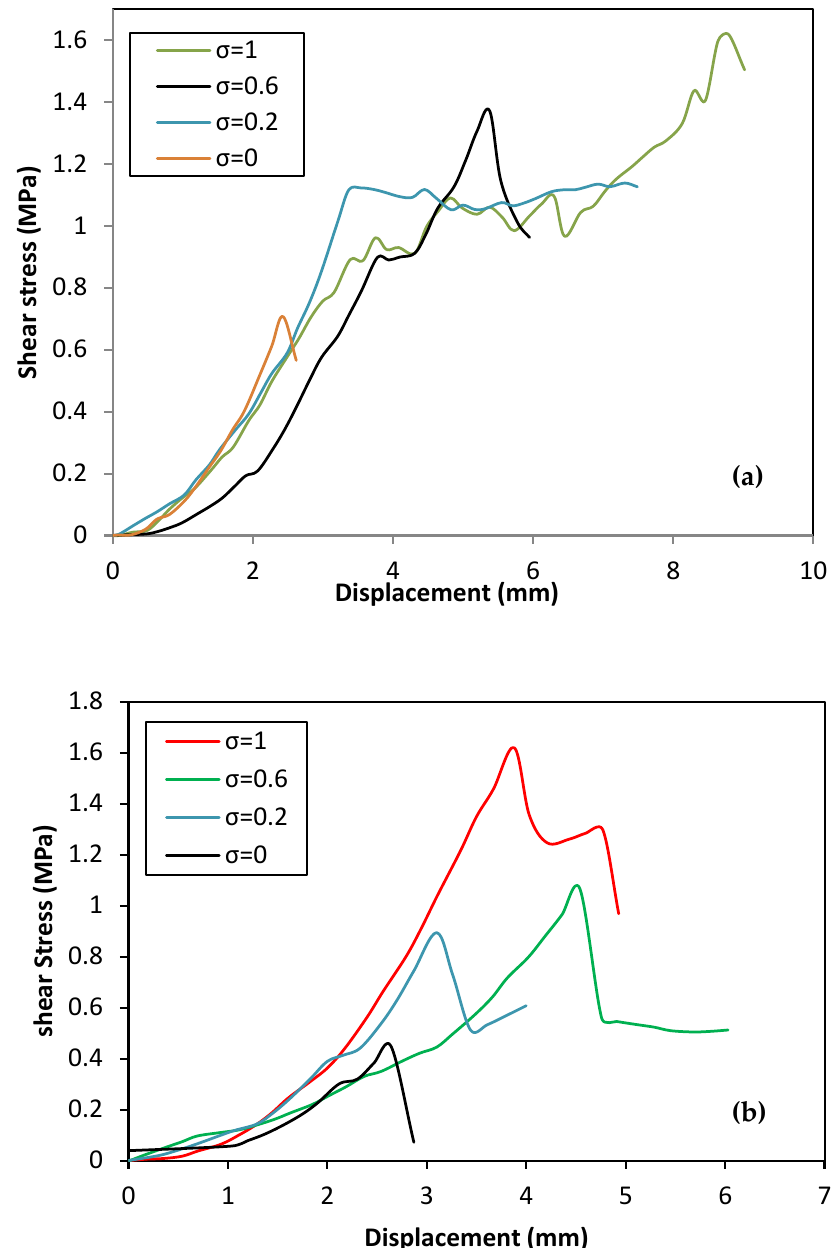
Figure 5. Stress-strain curves for various pre-compression levels for non-strengthened triplets: ( a ) STA, ( b ) STB.